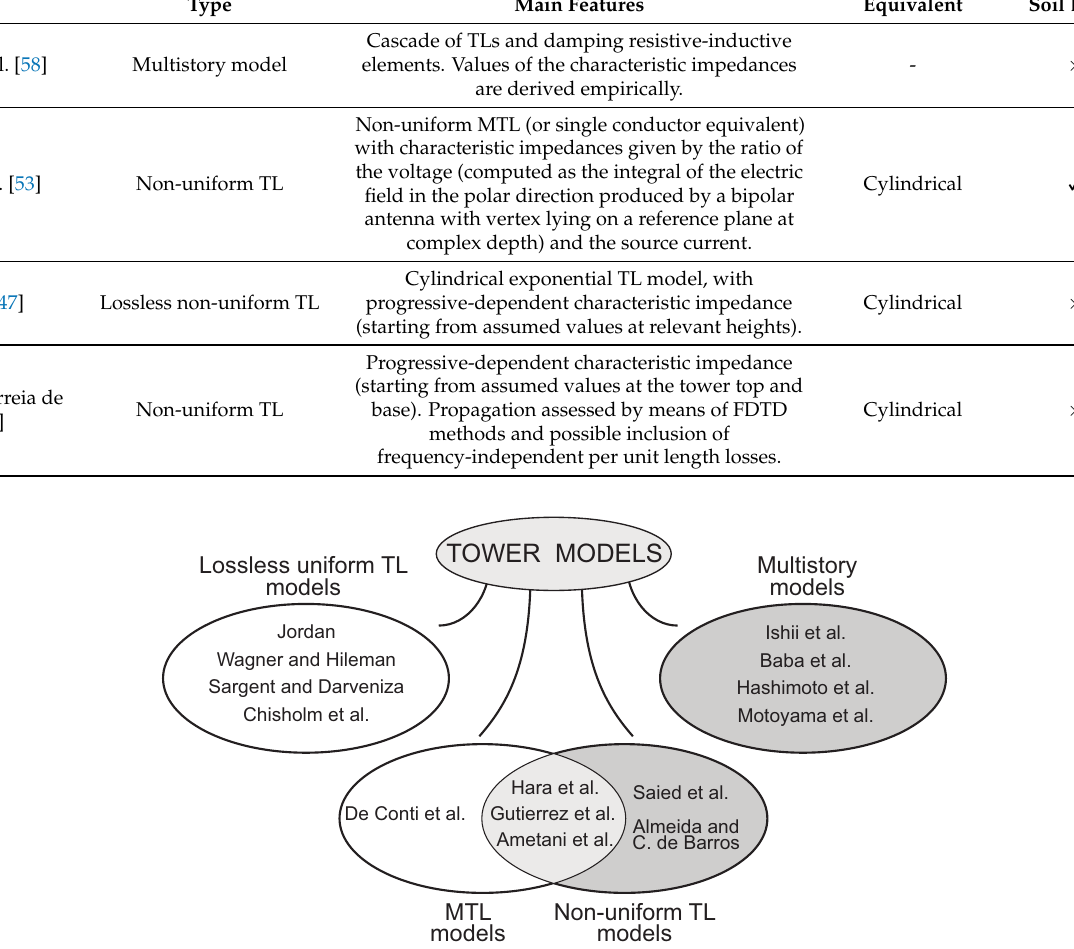
Figure 2. Classification of the reviewed circuit models for transmission line towers [21,39,42,43,45,47,